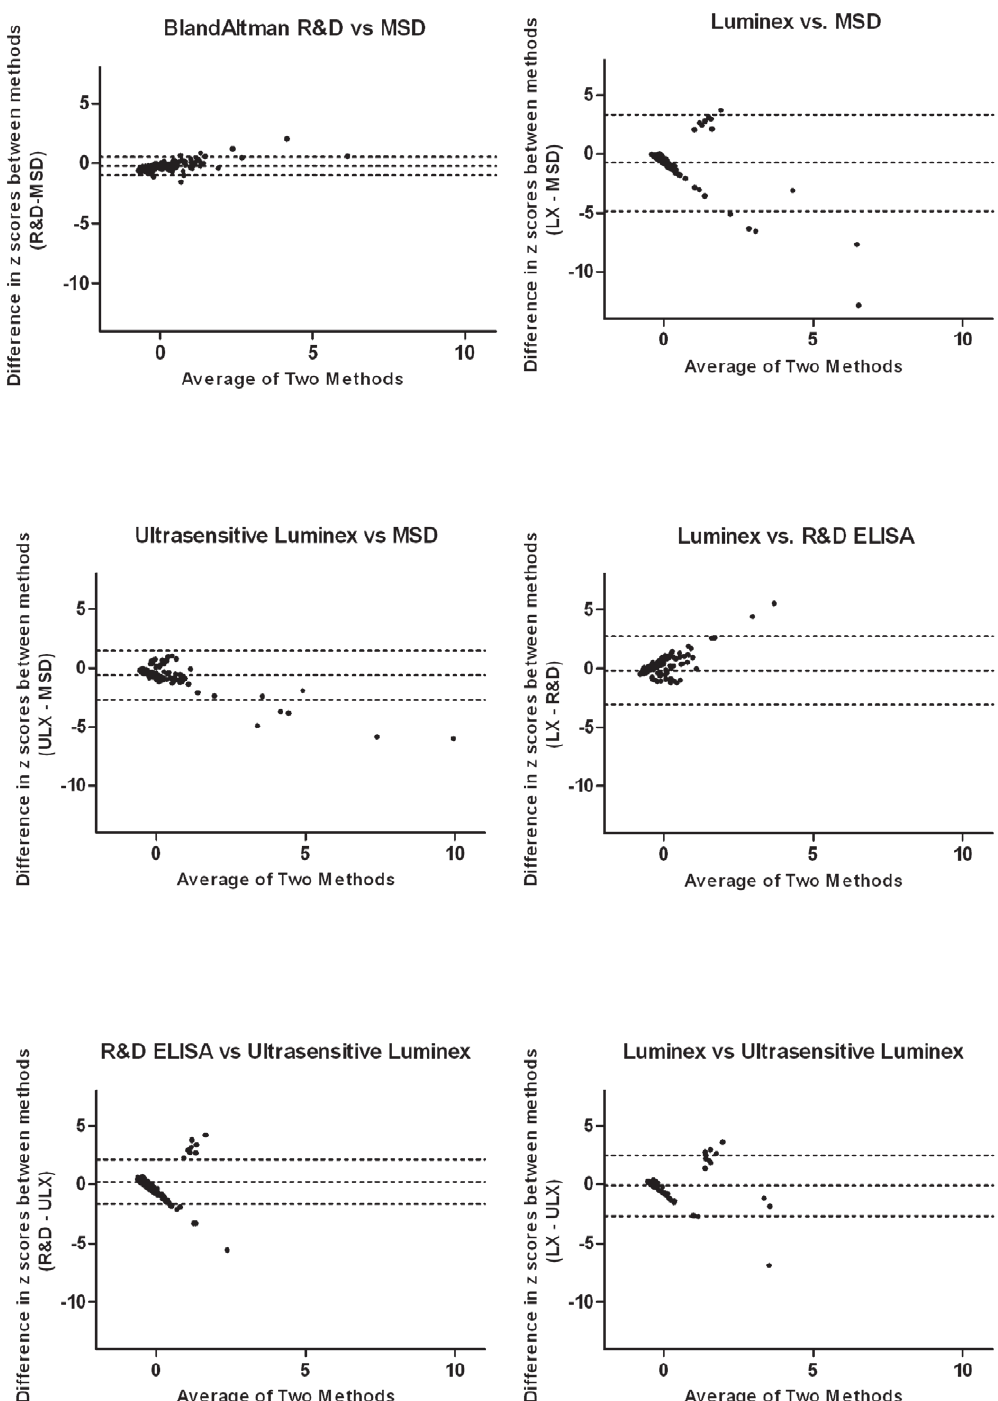
Figure 2. Modified Bland-Altman tests comparing four IL-6 immunoassays. IL-6 concentrations . IL-6 concentrations were standardized by calculating the z score using z=(x– m )/ s , where x is the raw concentration, and m and s are the mean and standard deviation of all concentrations for that assay. The limits of agreement are denoted by hatch marks representing the mean 6 2SD of the differences in measurements. Out of range values (LX n=57, ULX n=1, R&D n=7, as reported in Table 1) were excluded from these analyses.